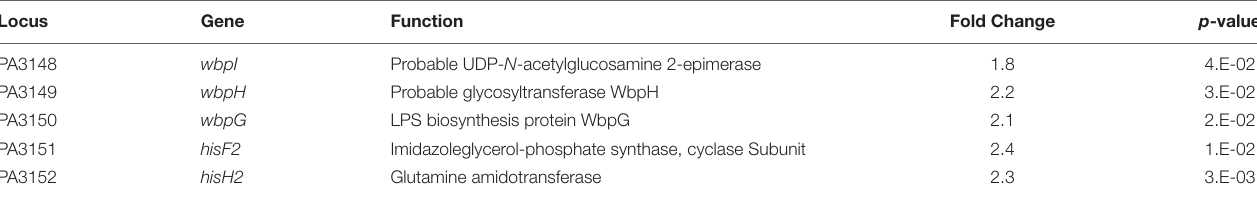
Locus Gene Function Fold Change